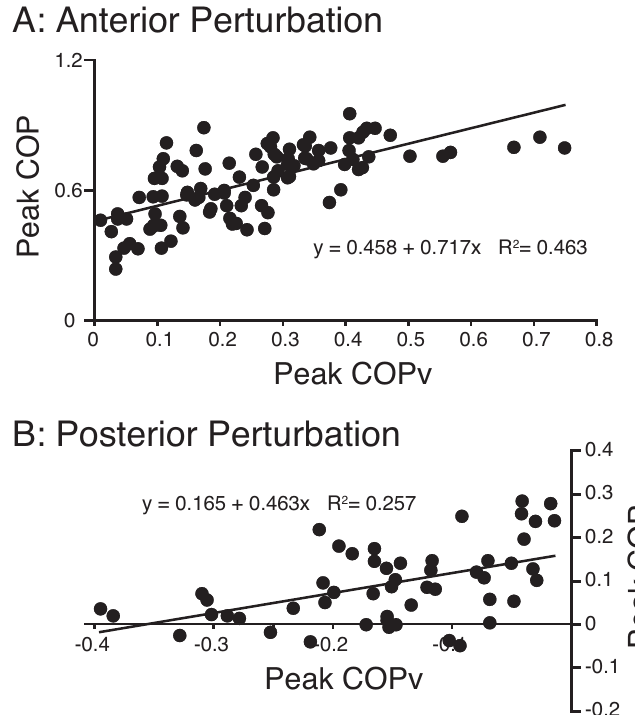
Figure 2 . COP peak vs. COPv peak from all the anterior perturbation trials (A) and from all the posterior perturbation trials